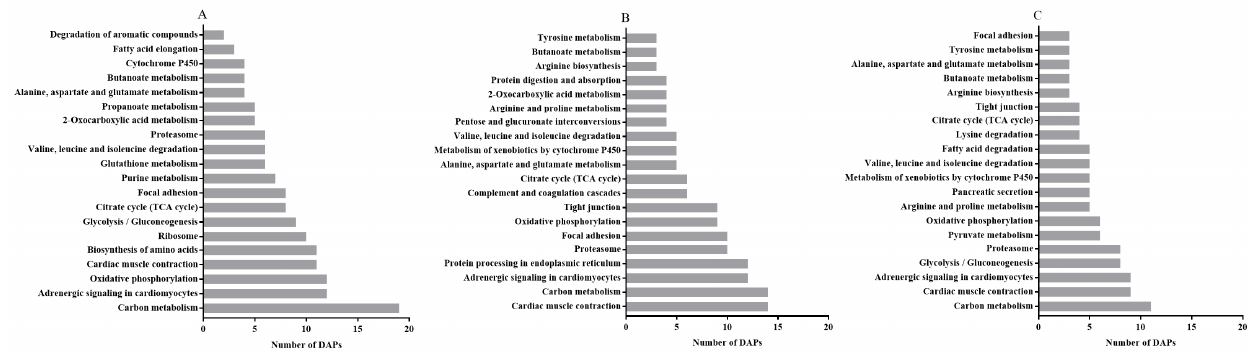
Figure 4. The 20 most enriched terms of differentially abundant proteins (DAPs) by Gene Ontology (GO) analysis between the CON and LP groups on days 0 ( A ), 5 ( B ) and 7 ( C ). BP, biological process; CC, cellular component; MF, molecular function. DAPs: differentially abundant proteins.